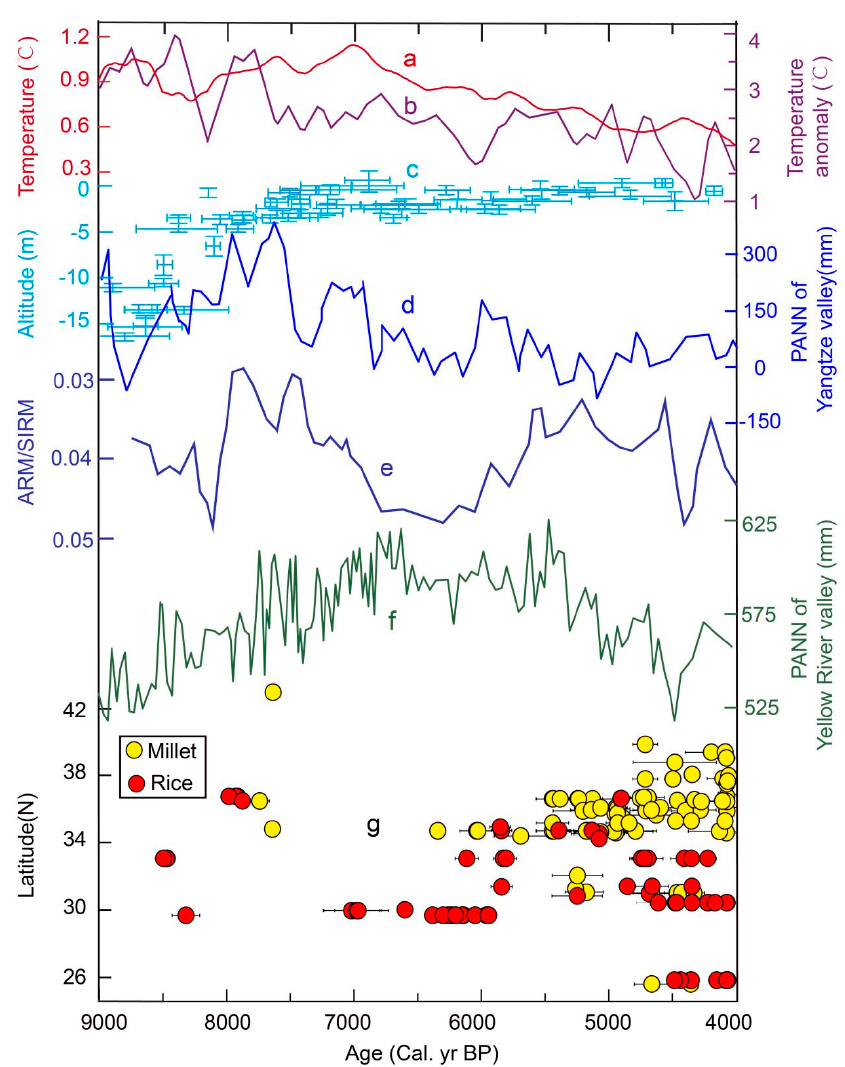
Figure 4. Comparison of ( a , b ) temperature anomaly in the Northern Hemisphere (30–90 ◦ N) [15] and High Arctic [63]; ( c ) reconstructed sea-level change [64]; ( d ) pollen-based annual precipitation (PANN) in the Yangtze River valley [61]; ( e ) stalagmite ARM/SIRM record from the Heshang Cave [62]; ( f ) reconstructed PANN from Gonghai lake [54]; ( g ) latitudinal distribution of Neolithic sites with unearthed rice or millet sites between 9000–4000 BP.